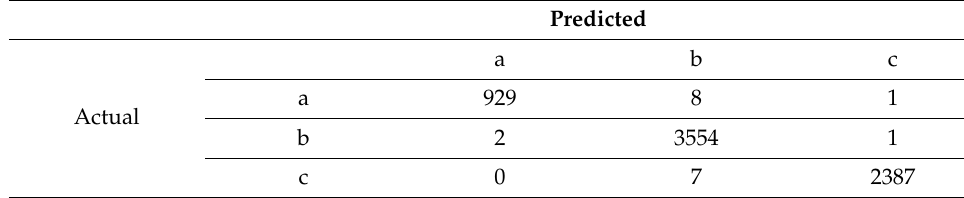
Table 8. The AdaBoost (SVM) confusion matrix with a high misclassification rate.